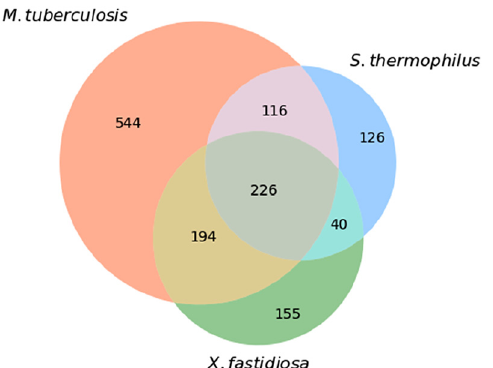
Figure 4: Venn diagram of the metabolic COGs obtained with recog- niser for M. tuberculosis, S. thermophilus and X. fastidiosa. Venn diagramsshowthenumberofuniqueCOGidentifierssharedbetween the three